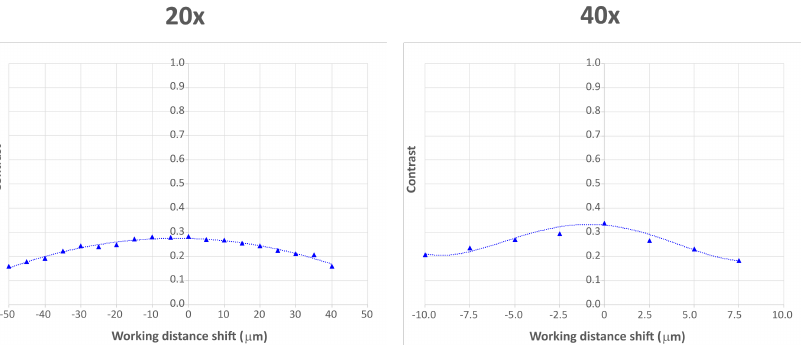
Figure 6. Contrast values over working distance shift for both 20x and 40x objective. The triangles are the experimentally measured values, the dotted lines are the trend lines. The working distance shift has a value 0 when the USAF chart is at the object plane, it has negative values when the USAF chart is moved further from the objective and positive values when the USAF chart is moved closer to the